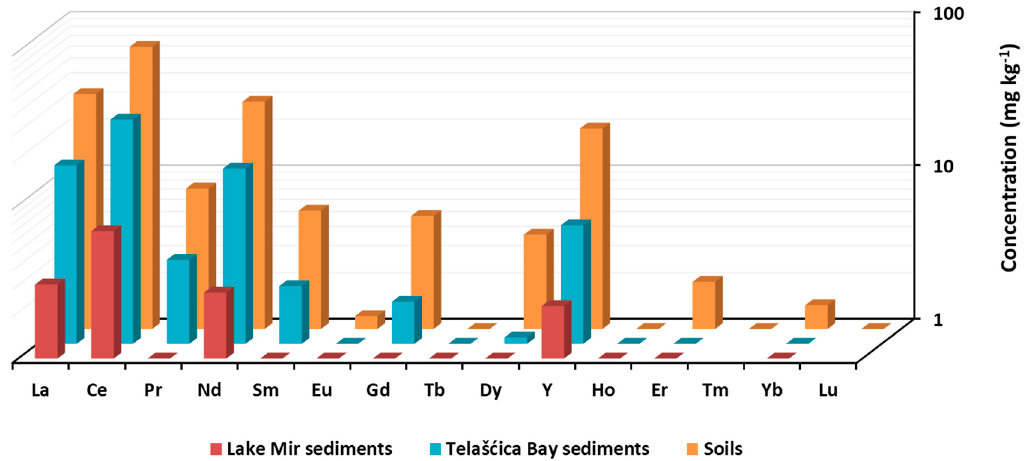
Figure 2. The average concentrations of rare earth elements and Y in the Lake Mir sediments, the Telaš´cica Bay sediments, and soils surrounding the